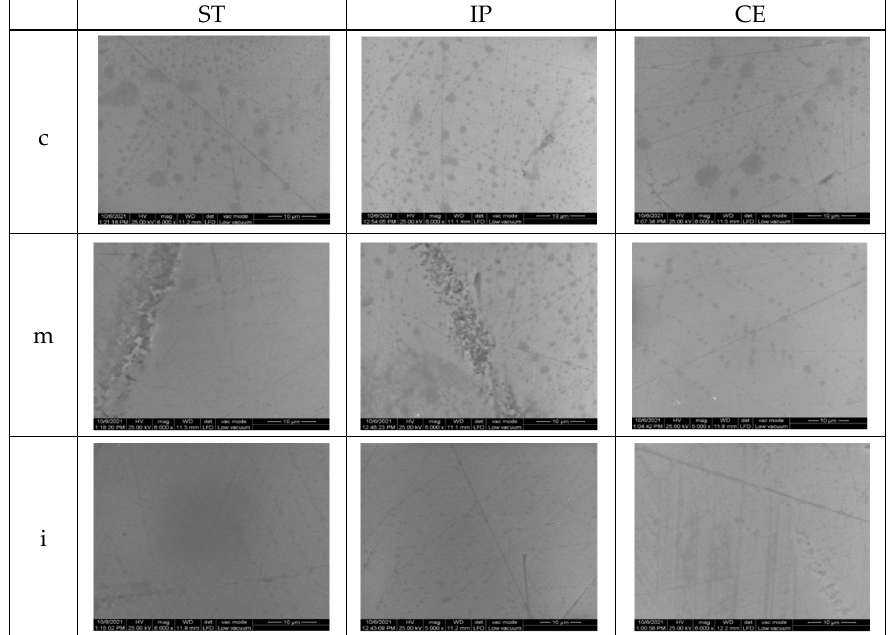
Figure 8. SEM images for polished samples before aging.ST= STML, IP= IPS e.maxZirCAD CEREC/in Lab MT Multi, CE= CeramillZolidfx ML, c = cervical, m = medium, i = incisal.